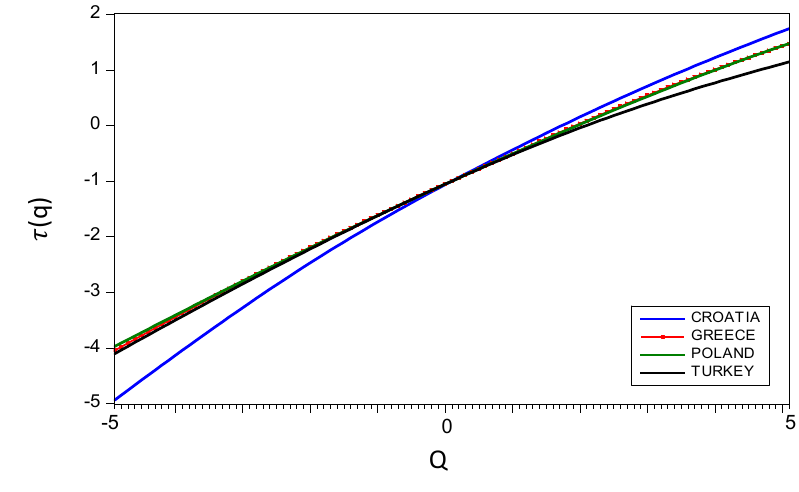
Figure 2. Classical multifractal scaling exponent τ ( q ) versus q .